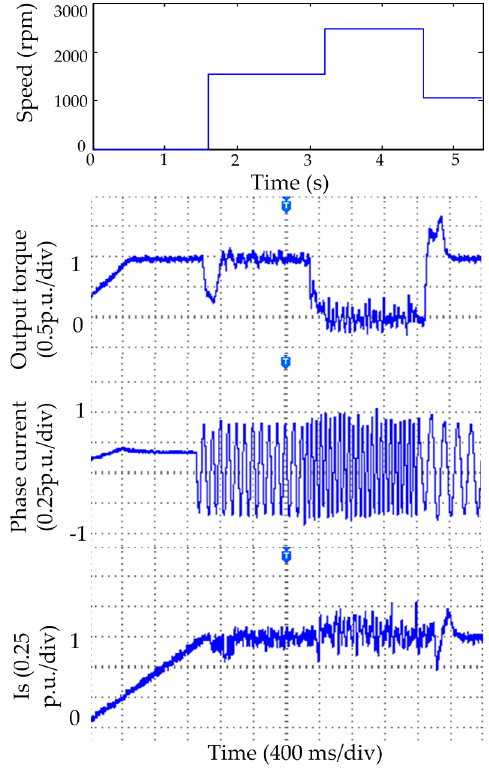
Figure 16. Dynamic response to speed reference step variation with the proposed control strategy when torque command is 90 nm.